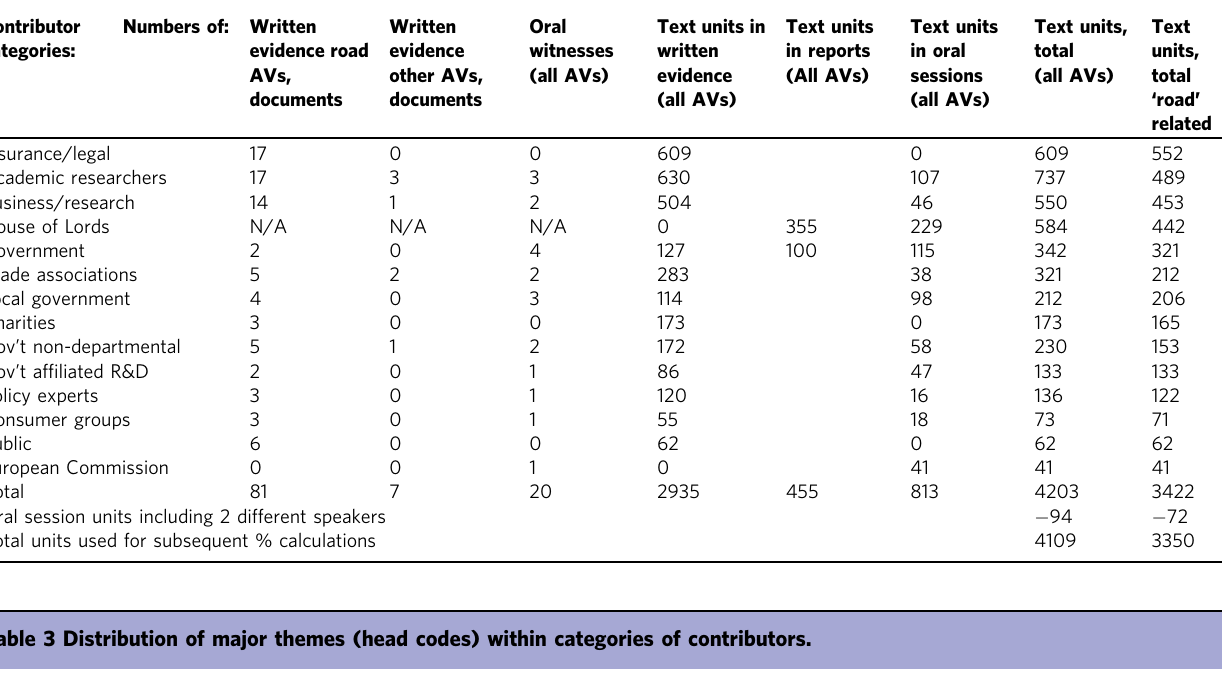
Class of contributor